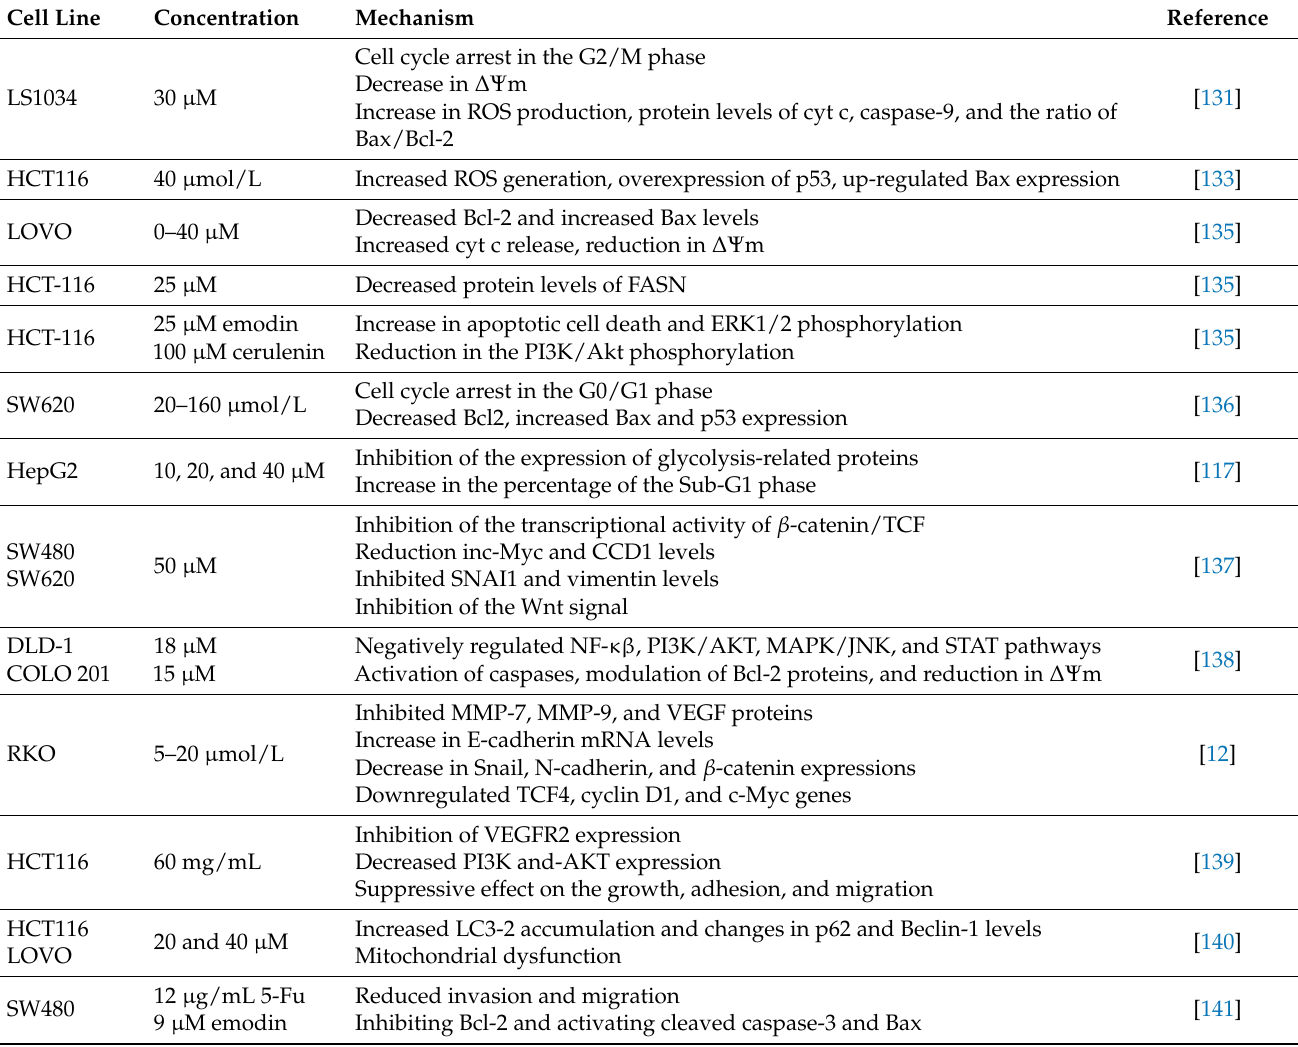
Table 6. Summary of in vitro biochemical effects of emodin in colon cancer cell lines. Cell